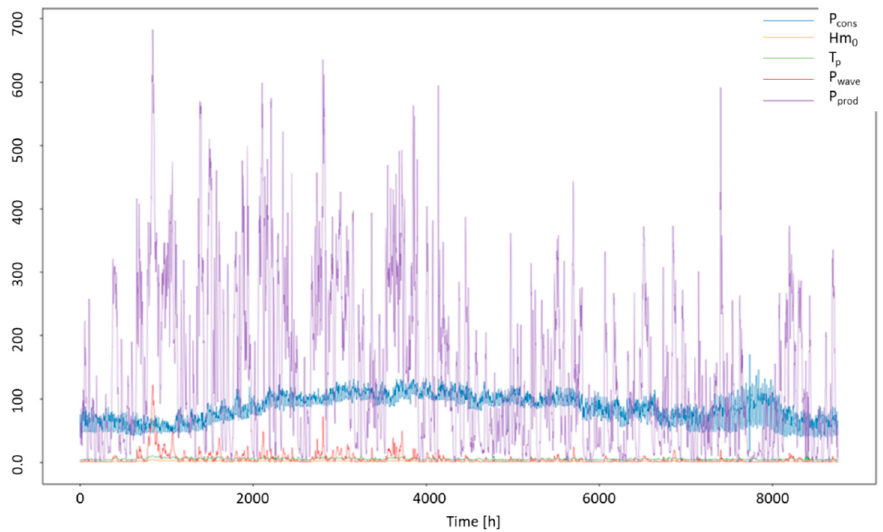
Figure 6. Power consumption, Power production and Power per meter of wave crest (Pcons, Pprod and Pwave) in kW for 2016, 4 Weptos configuration.